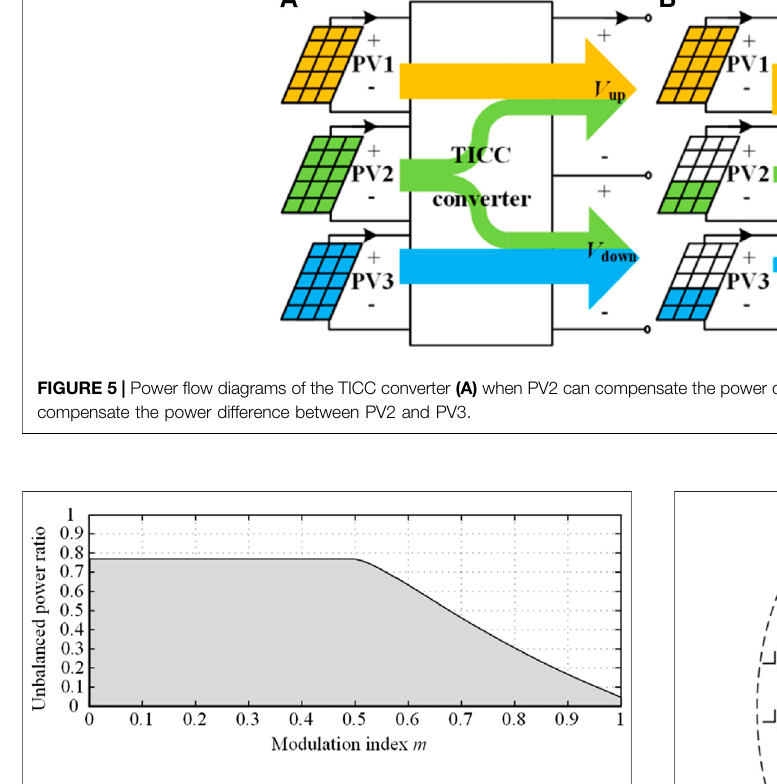
FIGURE 6 | Voltage balance limit of the NPC inverter using SVM.